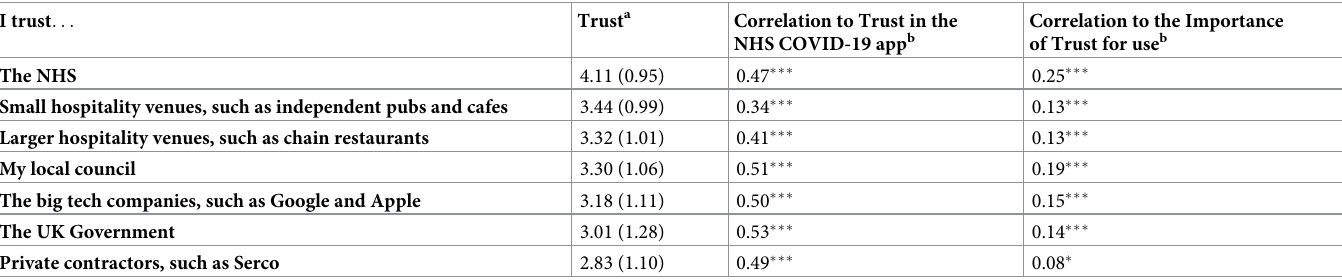
Table 4. Trust in groups involved in the Test and Trace system, and their relationship to trust in the app. I trust ... Trust a Correlation to Trust in the